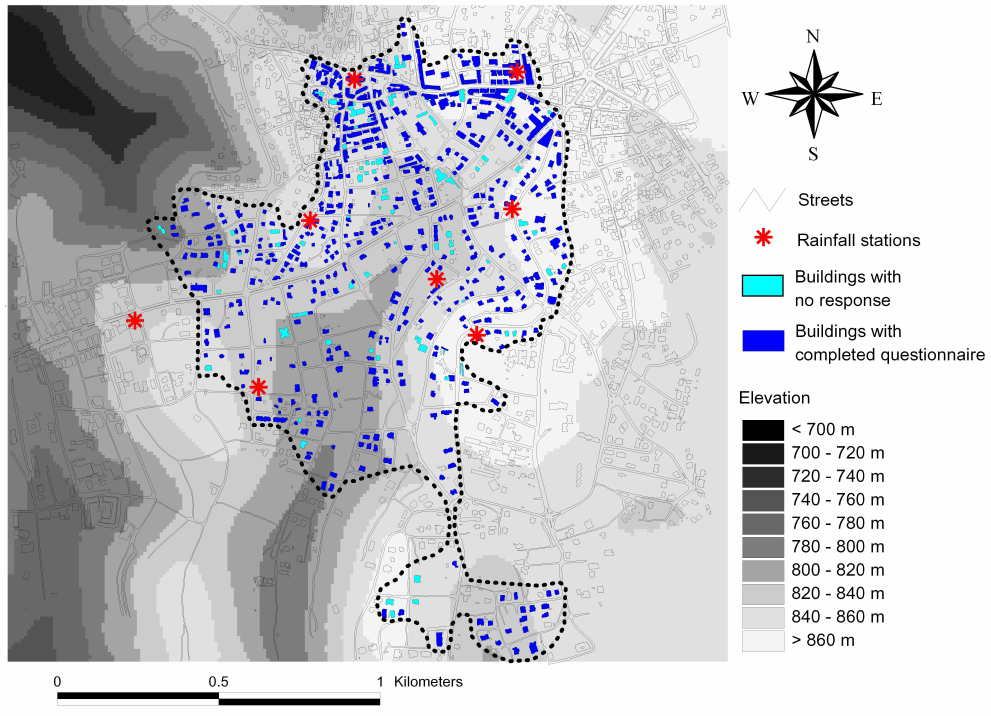
Fig. 3. Investigated city district inside Ramallah, buildings with residents surveyed and installed rainfall stations.